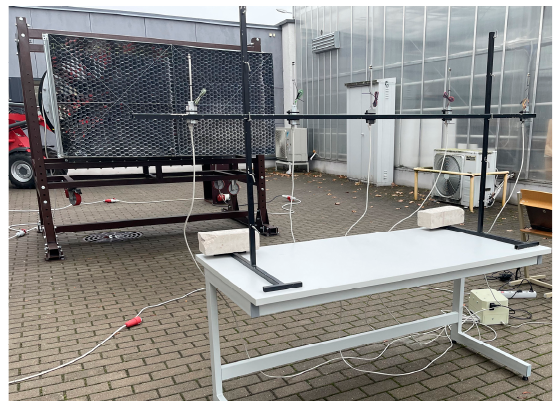
Figure 4. Air velocity determination equipment.